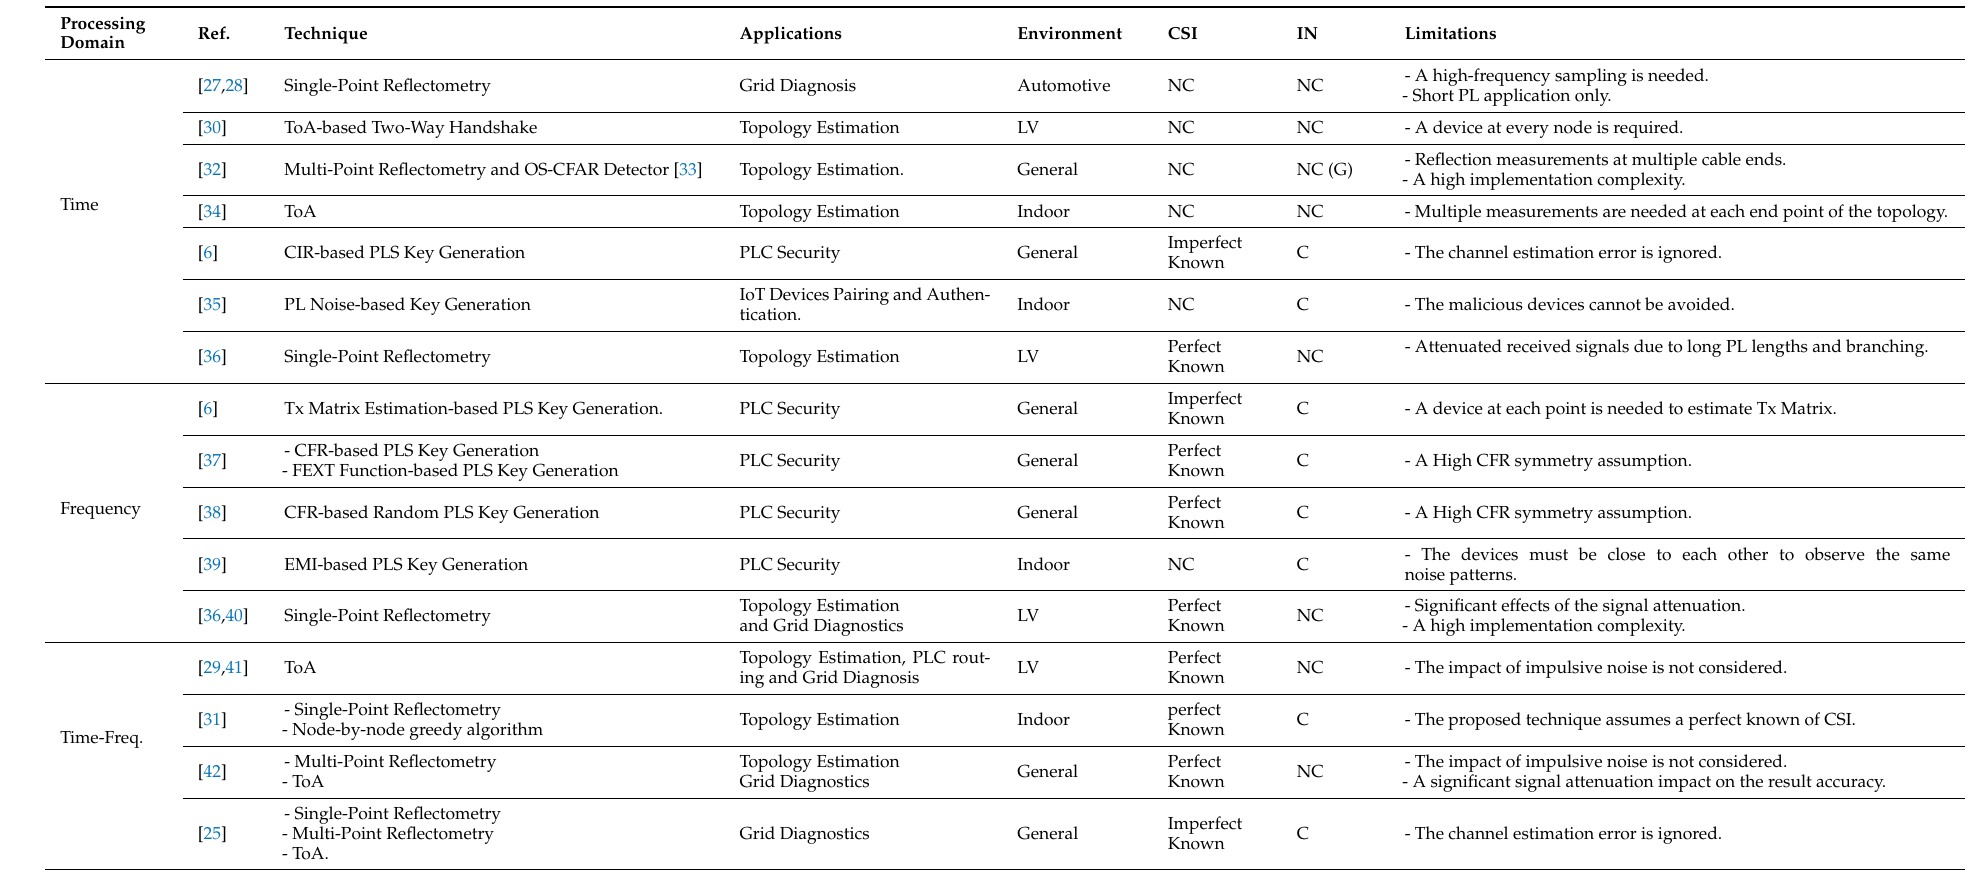
Table 1. PLC Signal-based Solutions.